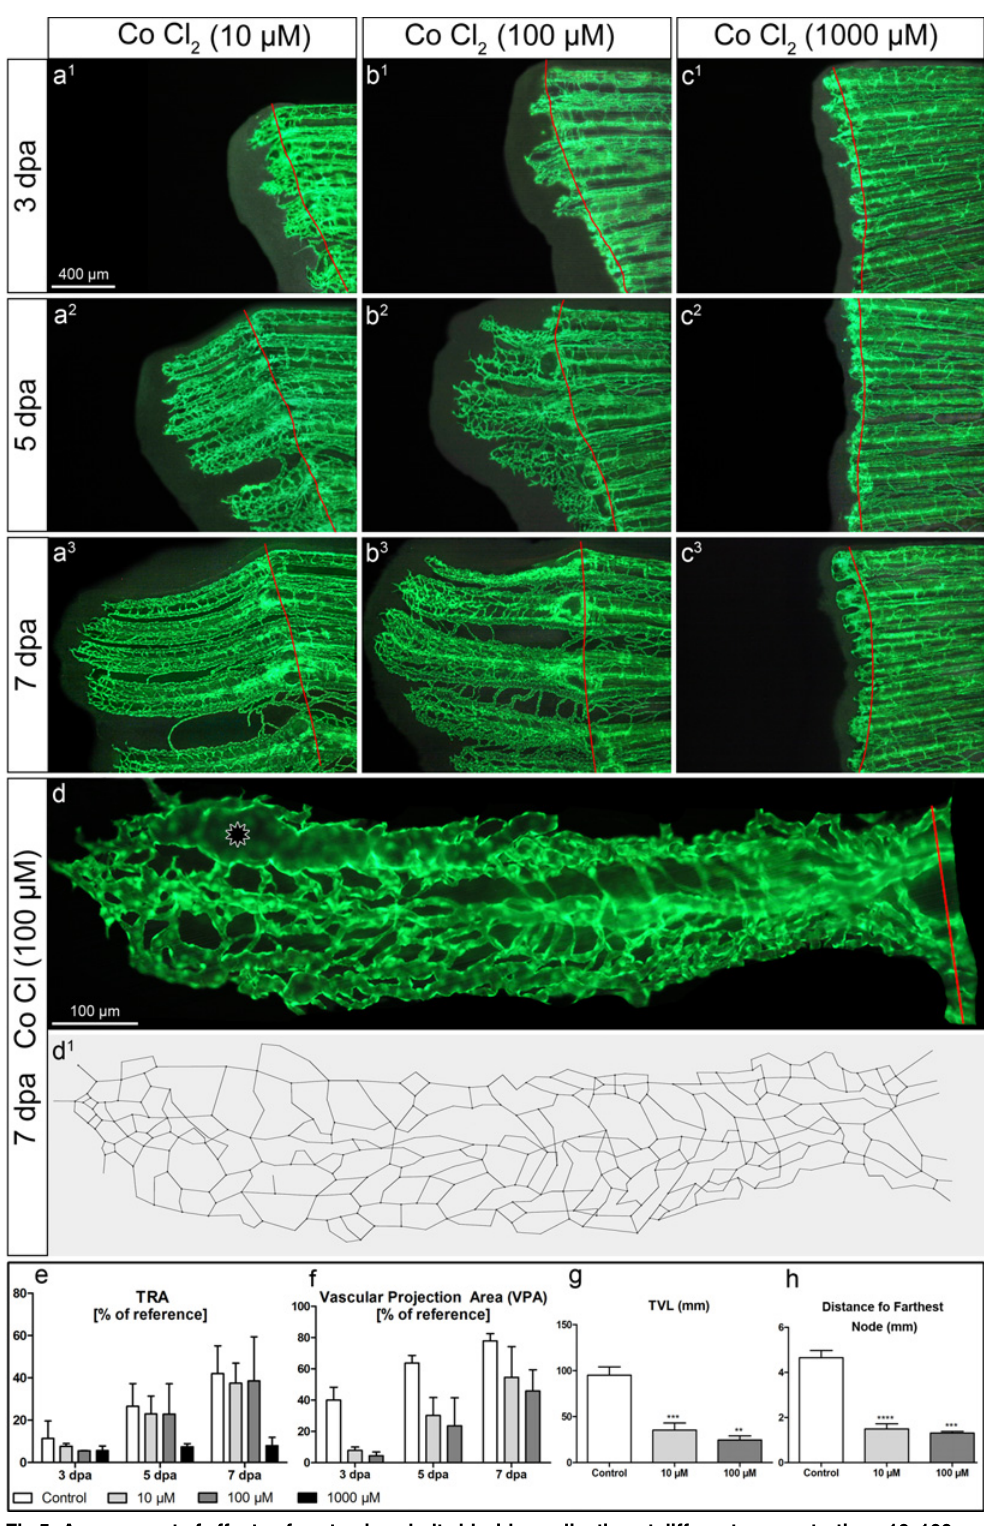
Fig 5. Assessment of effects of systemic cobalt chloride application at different concentrations 10, 100 and 1000 μ M. a-c Fluorescent images of regenerating caudal fins at 3 ( a1-c1 ), 5 ( a2-c2 ) and 7 dpa ( a3-c3 ) under 3 different conditions: 10 μ M (left column), 100 μ M (middle) and 1000 μ M of cobalt chloride (right column). Based on the high-magnification images of the single fin rays at 7 dpa ( d ), the skeletons of the regenerating vasculature at 7dpa were